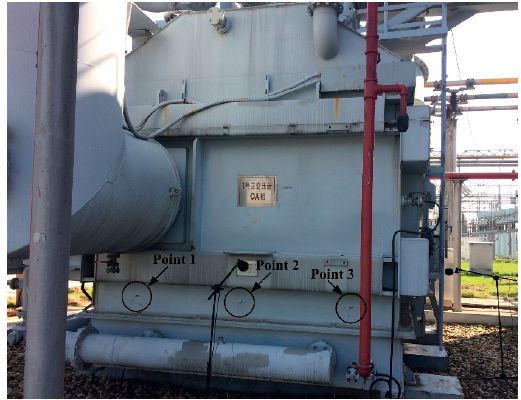
Figure 1. Locations of the vibration measurement points.